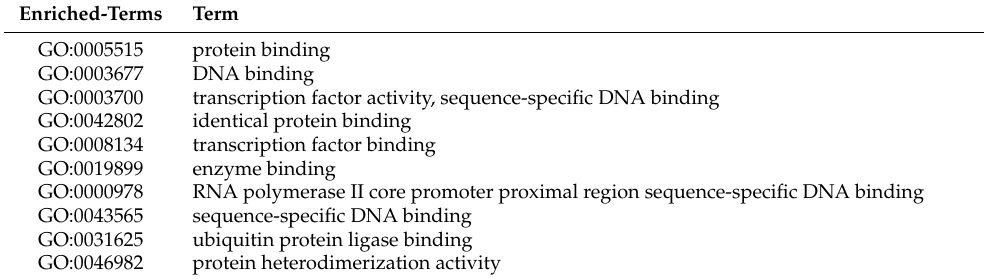
Table A2. Lists of top-10 enriched terms and the corresponding molecular function.